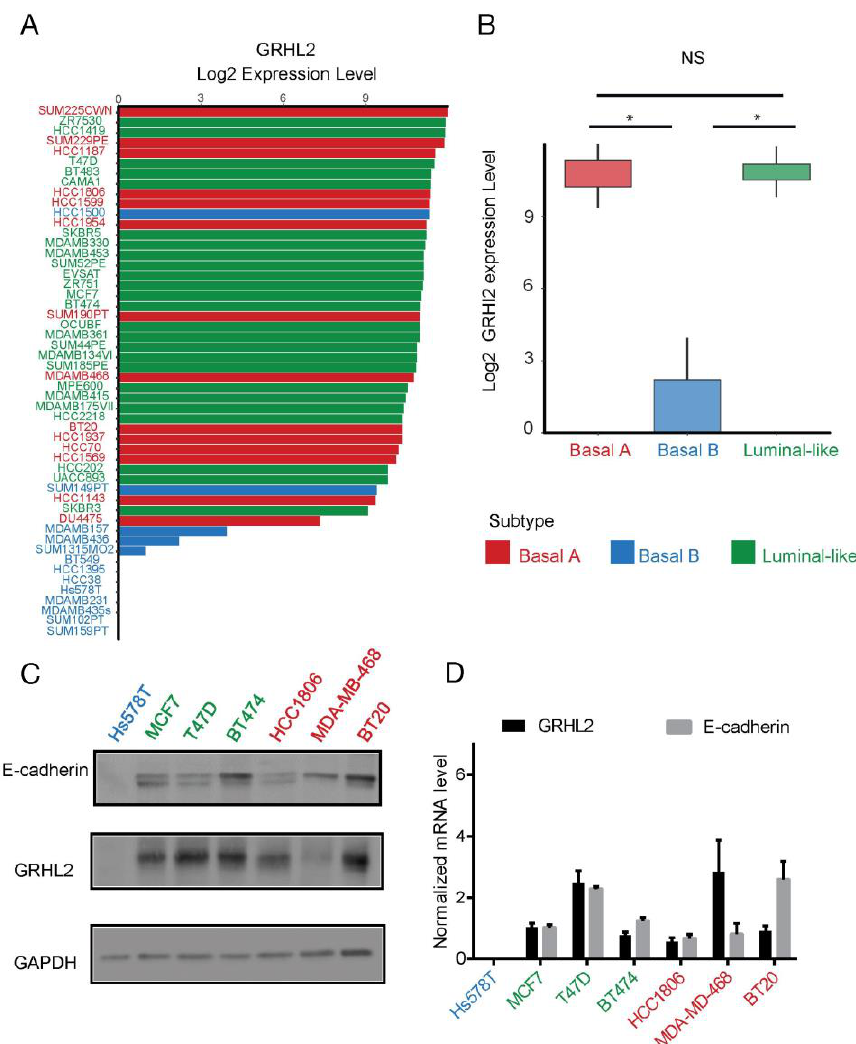
Figure 2. GRHL2 expression in a panel of human breast cancer cell lines representing different subtypes. ( A , B ) GRHL2 expression in a panel of > 50 human breast cancer cell lines covering luminal, basal A, and basal B subtypes extracted from RNA-seq data. * indicates p < 0.05; NS, not significant. ( C , D ) Western blot analysis ( C ) and qRT-PCR ( D ) showing loss of GRHL2 and its target gene CDH1 in basal B subtype breast cancer. Color codes refer to ( B ).